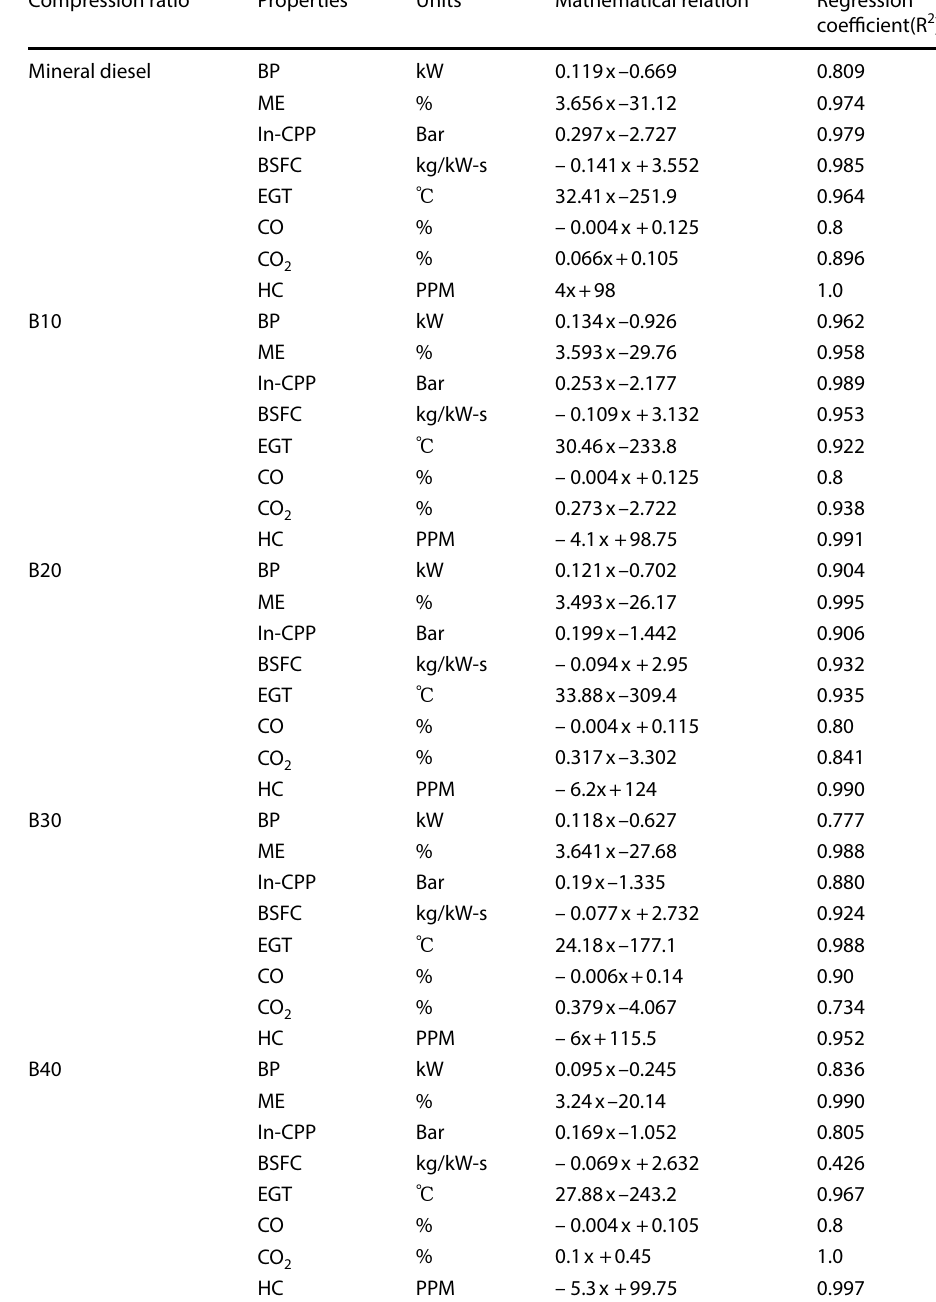
Table 9 The mathematical relation between different engine output parameters and compression ratio (x) for various dual biodiesel sample blends and mineral